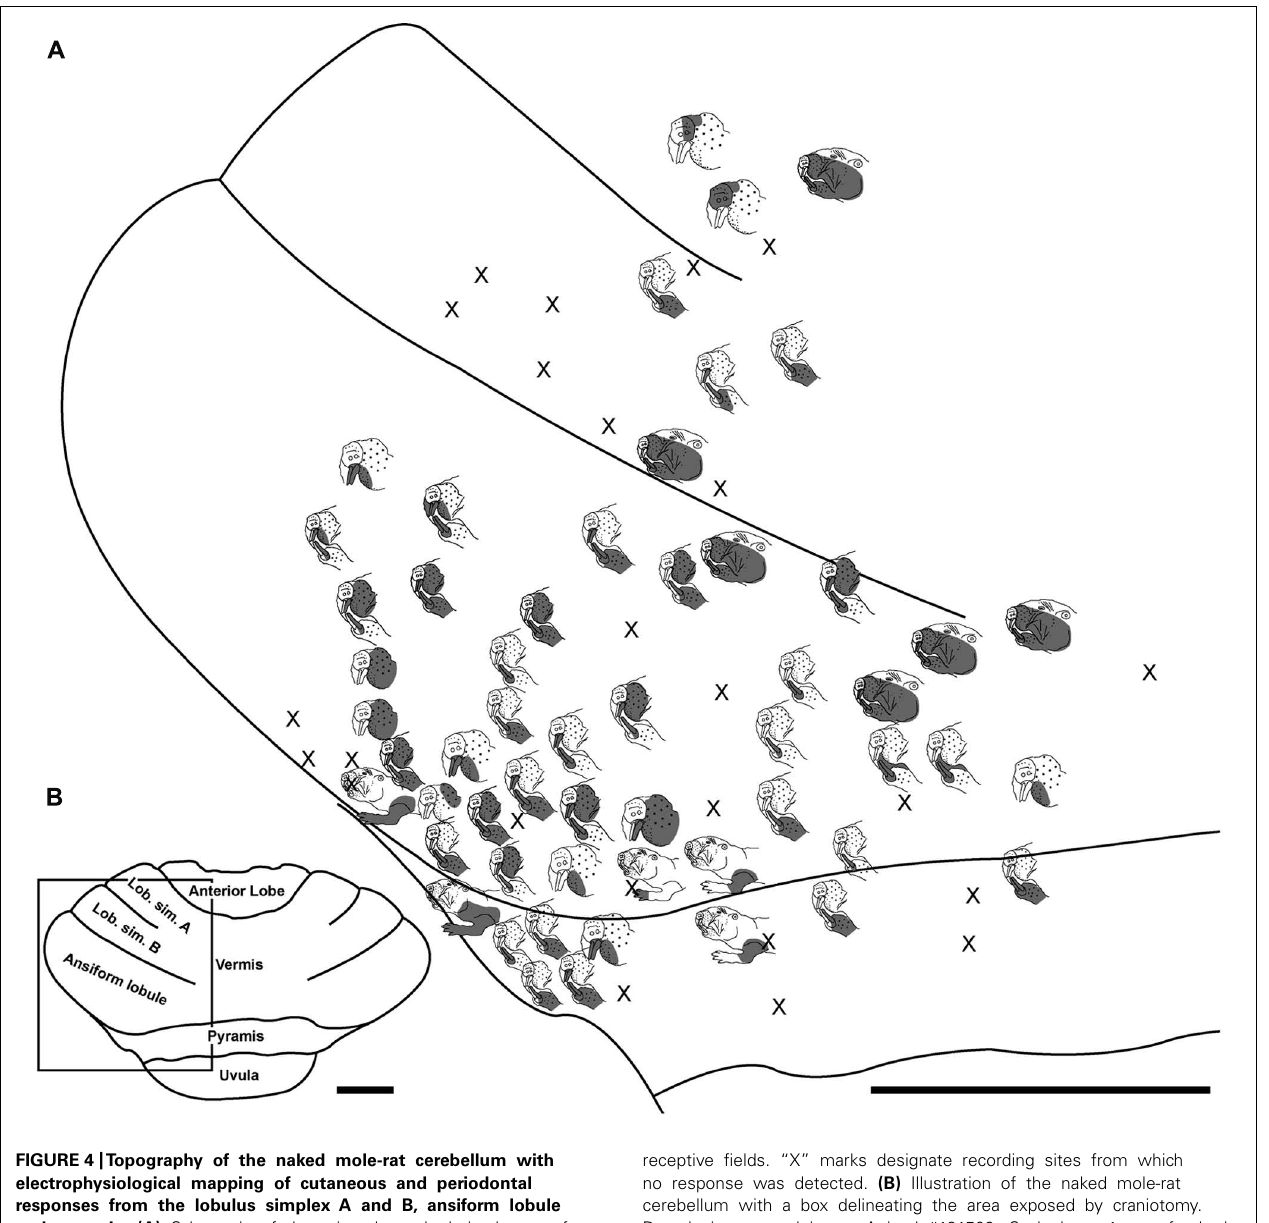
receptive fields. “X” marks designate recording sites from which no response was detected. (B) Illustration of the naked mole-rat cerebellum with a box delineating the area exposed by craniotomy. Dorsal view, rostral is up. Animal #121509. Scale bars: 1 mm for both (A,B)